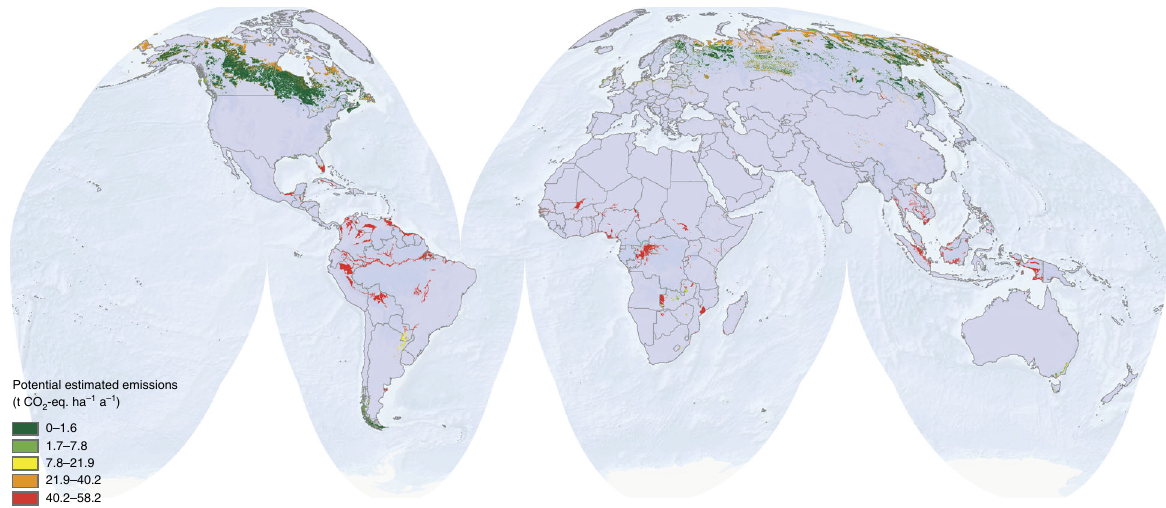
Fig. 1 Global peatland distribution and annual potential emissions from peatland degradation. The colored area indicates the areal distribution of peatlands globally. Legend colors refer to per hectare greenhouse gas emissions if those peatland would be drained. High potential emissions are associated with intensive land use and warm climate, low potential emissions with low land-use intensity in cold